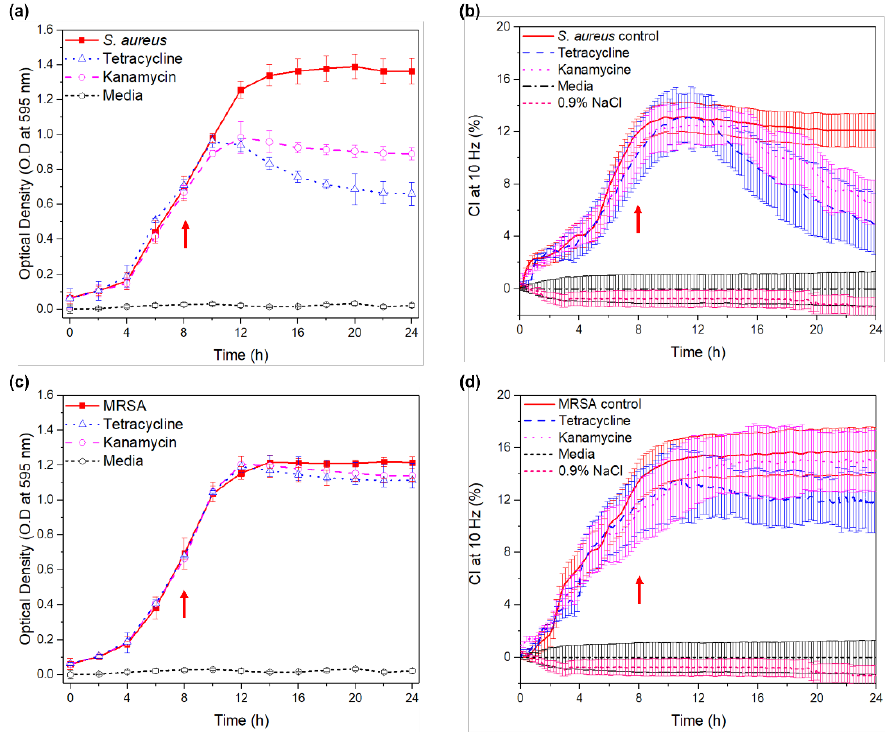
Figure 6. E ff ect of antibiotics (tetracycline or kanamycin, each of 30 µ g / mL) on ( a , b ) S. aureus Figure 6. Effect of antibiotics (tetracycline or kanamycin, each of 30 μg/mL) on ( a , b ) S. aureus or ( c , d )